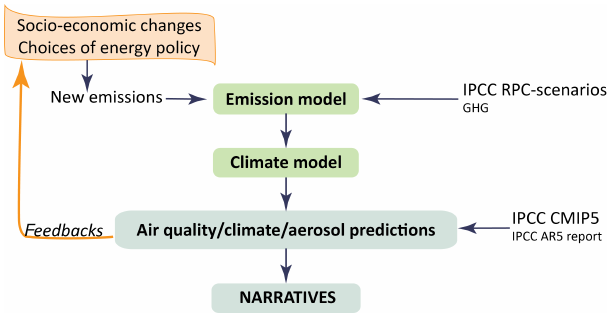
Figure 10. An example of the study approach to be implemented by PEEX for integrating natural science and social science knowledge and generating climate predictions and narratives of the northern